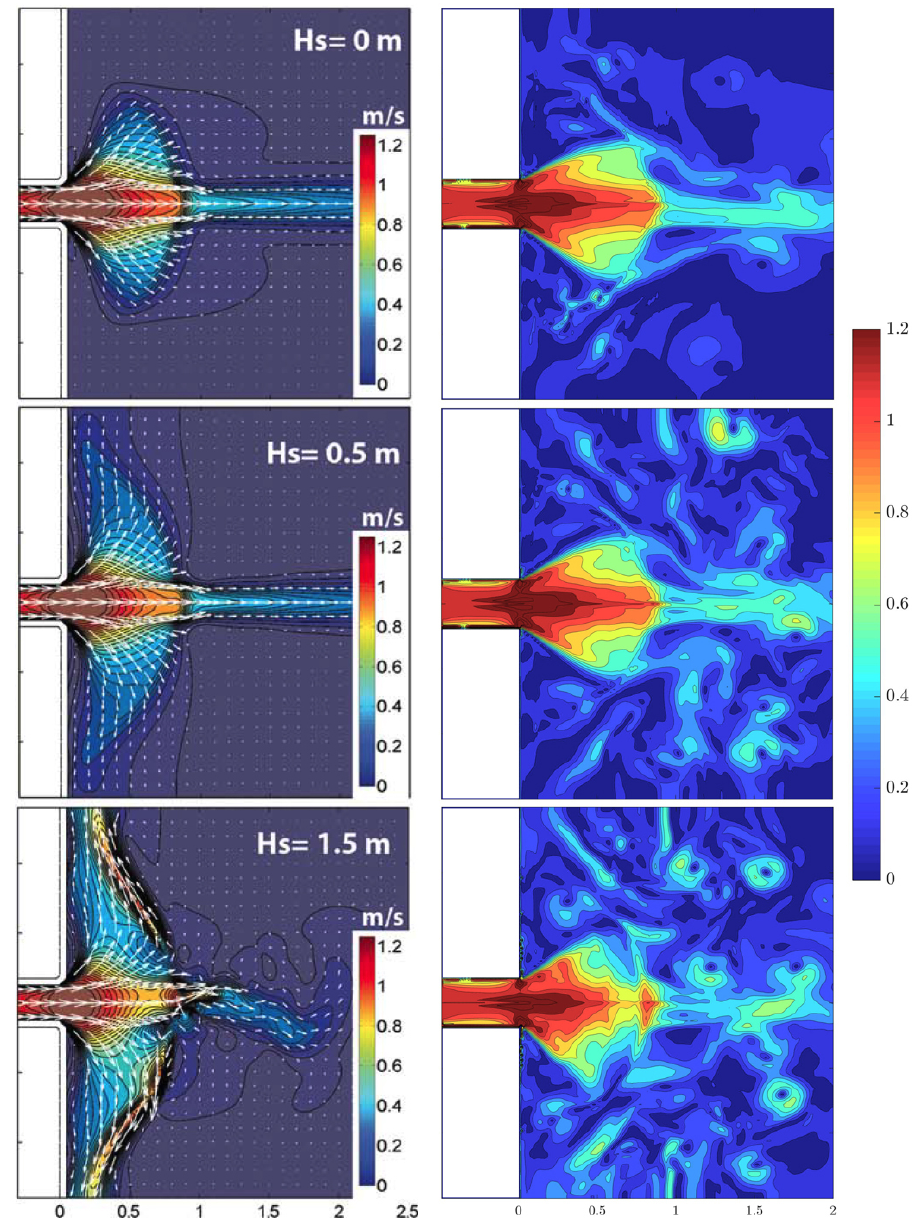
Figure 4. Comparison of velocity contour fields for a 1.1 m/s current (corresponding to strong outflow conditions in OL14) opposed to three different wave regimes (from top to bottom: no waves; waves with H s = 0.5 m; waves with H s = 1.5 m). ( Left ) velocity fields for the tests performed by OL14 (image reprinted with permission). ( Right ) velocity fields obtained using our NSWE solver and averaged over 10 wave